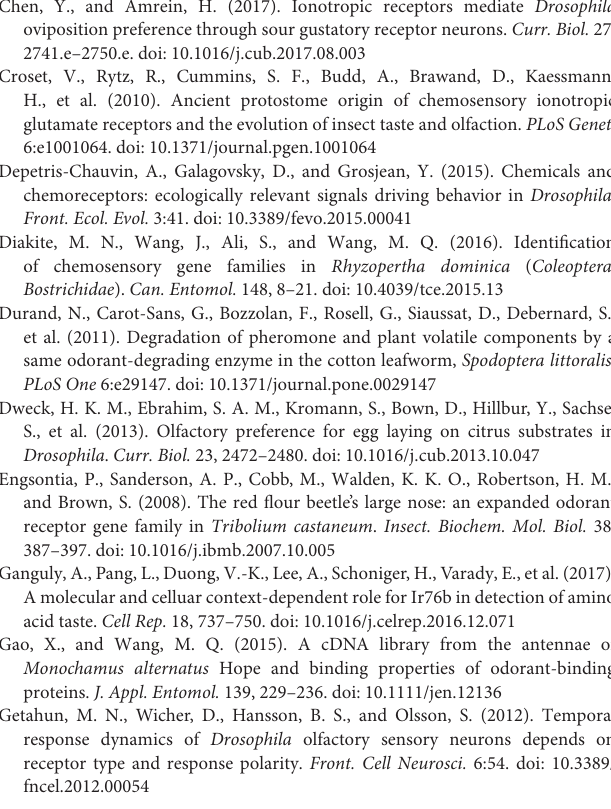
FIGURE S1 | Sequence length distribution of transcripts and unigenes assembled from Illumina reads for the mantle transcriptome of Apriona germari . The x -axis indicates the length interval of transcripts and unigenes, and the y -axis indicates the number of transcripts and unigenes for each size. FIGURE S2 | Relative mRNA expression of AgerORs in Apriona germari tissues. The relative mRNA levels were normalized to those of the actin gene and analyzed using the Q-gene method. All values are shown as mean ± SEM normalized. The